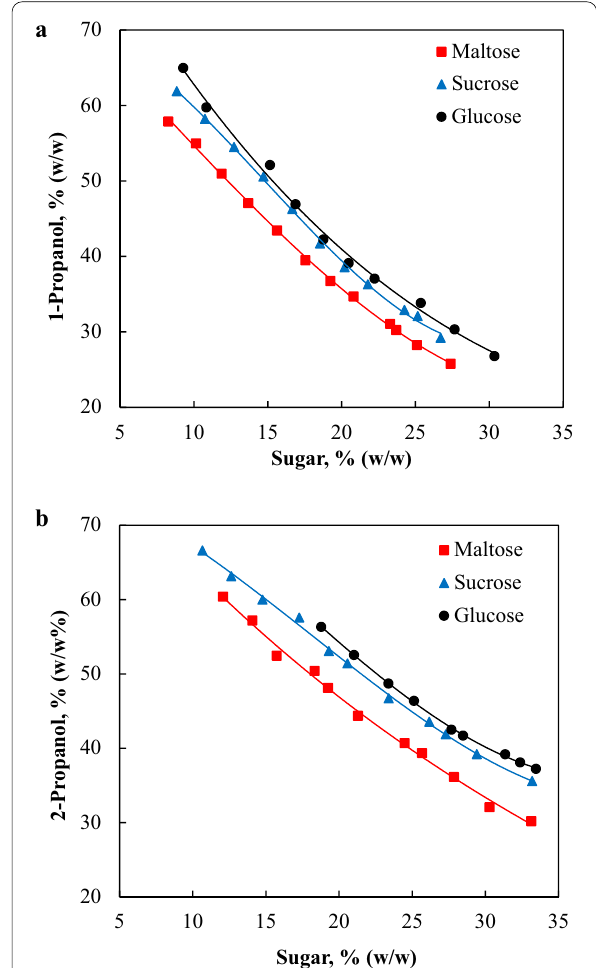
Fig. 1 Binodal curves of alcohol/sugar ABS. a Binodal curves of 1‑propanol/sugar ABS and b Binodal curves of 2‑propanol/sugar ABS. The solid lines of the binodal curves were obtained by connecting the sufficient points